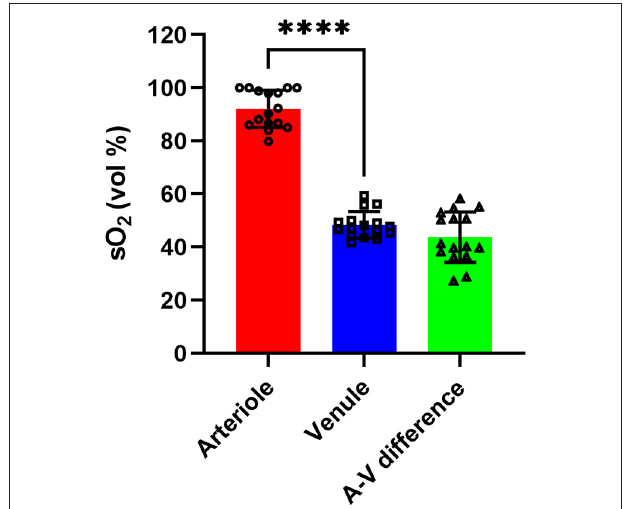
FIGURE 2 | The sO 2 of arterioles, venules, and A-V sO 2 difference from all eyes. **** p < 0.0001.